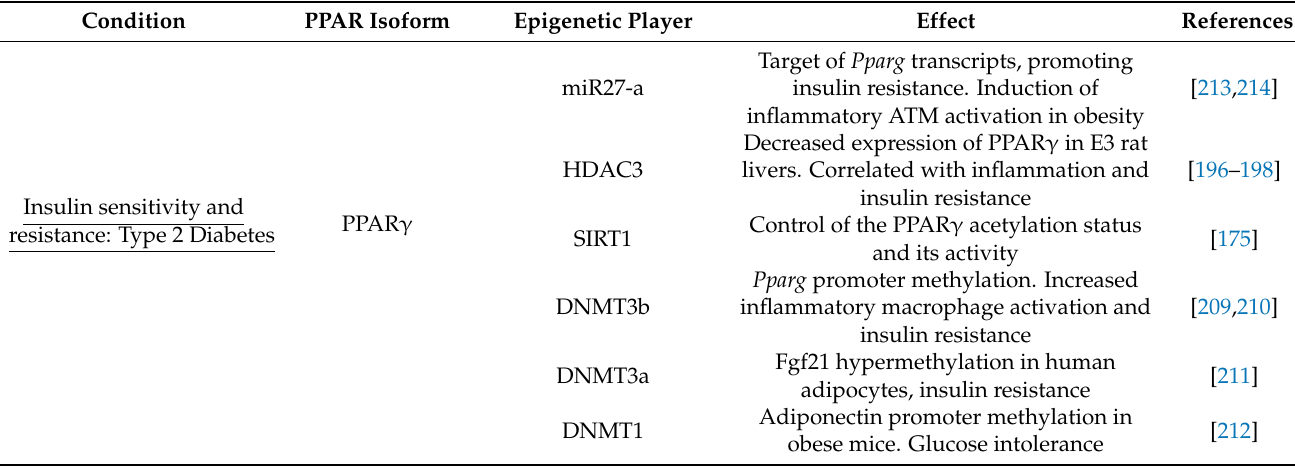
Table 6. PPAR epigenetics in type 2